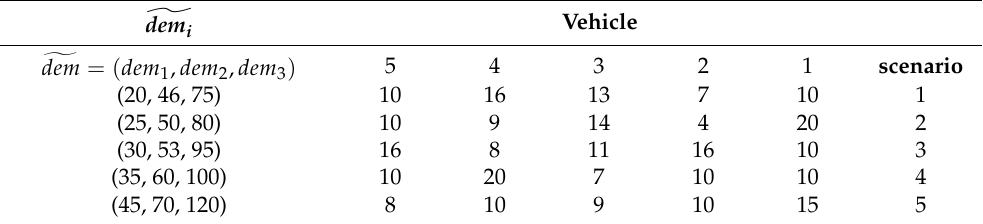
Table 6. The failure times and fuzzy demand for vehicles under different scenarios.